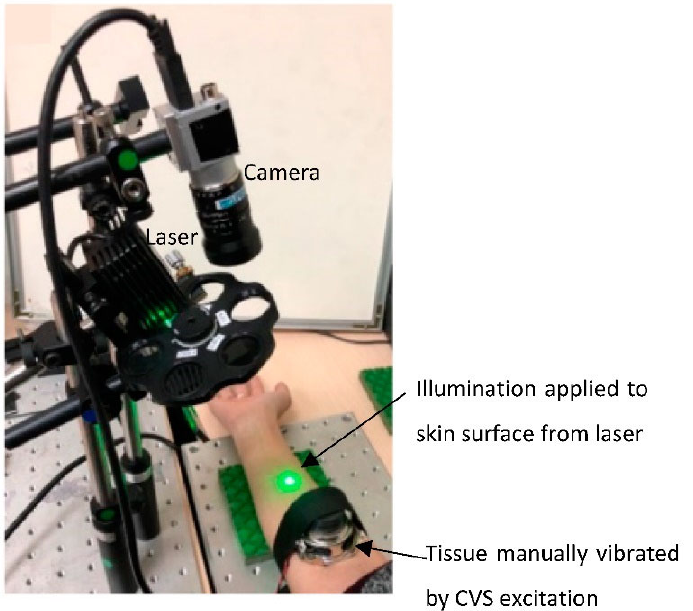
Figure 3. The experimental instrument for the optical setup, extracting the optical parameter to be compared to the Corneometer ® probe measuring capacitance. Modified from Kelman et al. [20].